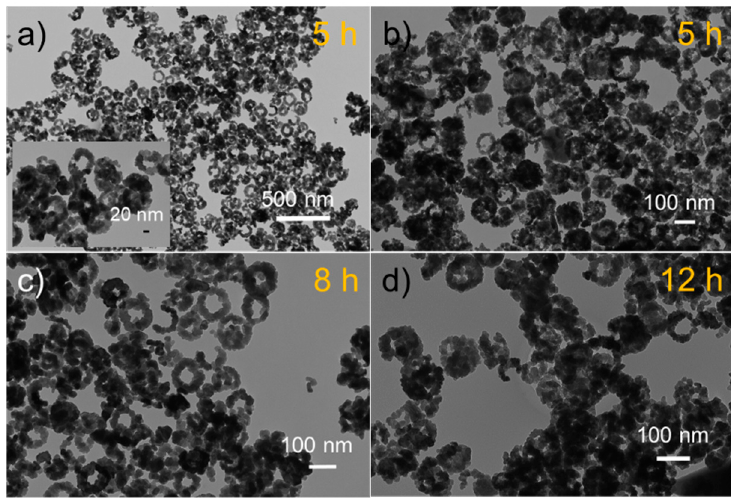
Figure 2. Representative bright-field TEM images of multigrain Fe 3 O 4 nanorings after hydrothermal reaction time: ( a , b ) 5 h, ( c ) 8 h, ( d ) 12 h. Inset of ( a ) shows a magnified view of the nanorings. Table 1. Crystallite size, dimensions, magnetic parameters including saturation ( M S ) and coercive field ( H C ), and specific absorption rate (SAR) at 300 K for Fe 3 O 4 nanorings.